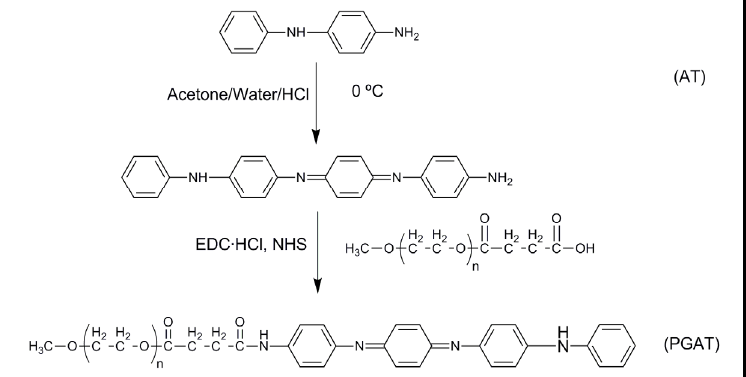
Figure 7. Synthesis scheme for the preparation of PGAT diblock copolymers.